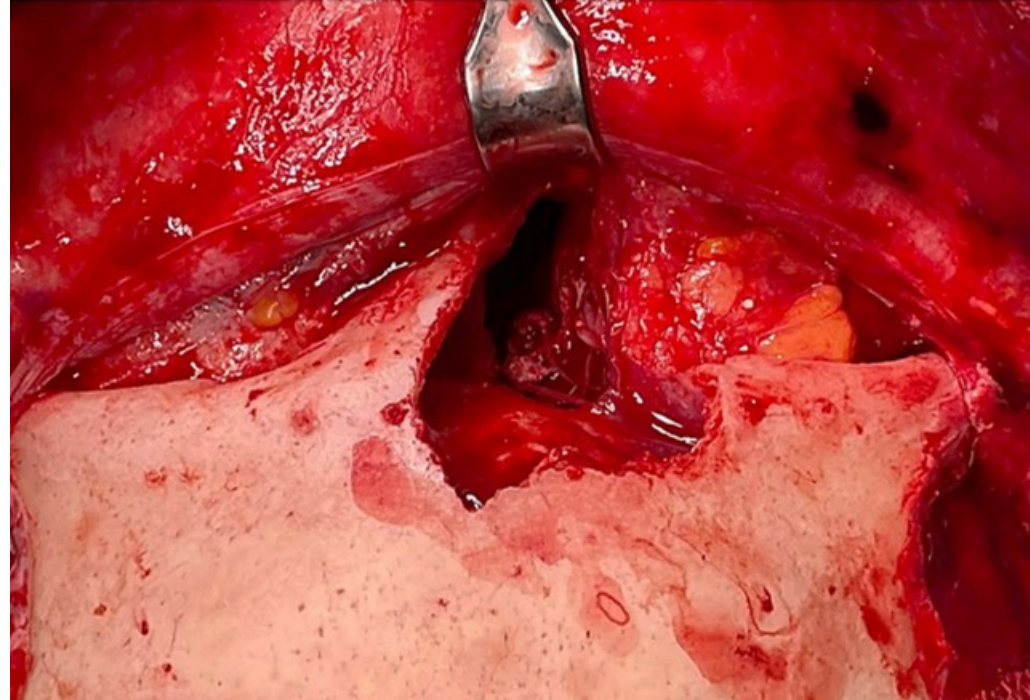
Figure 4. Intraoperative view after complete removal of the tumor.